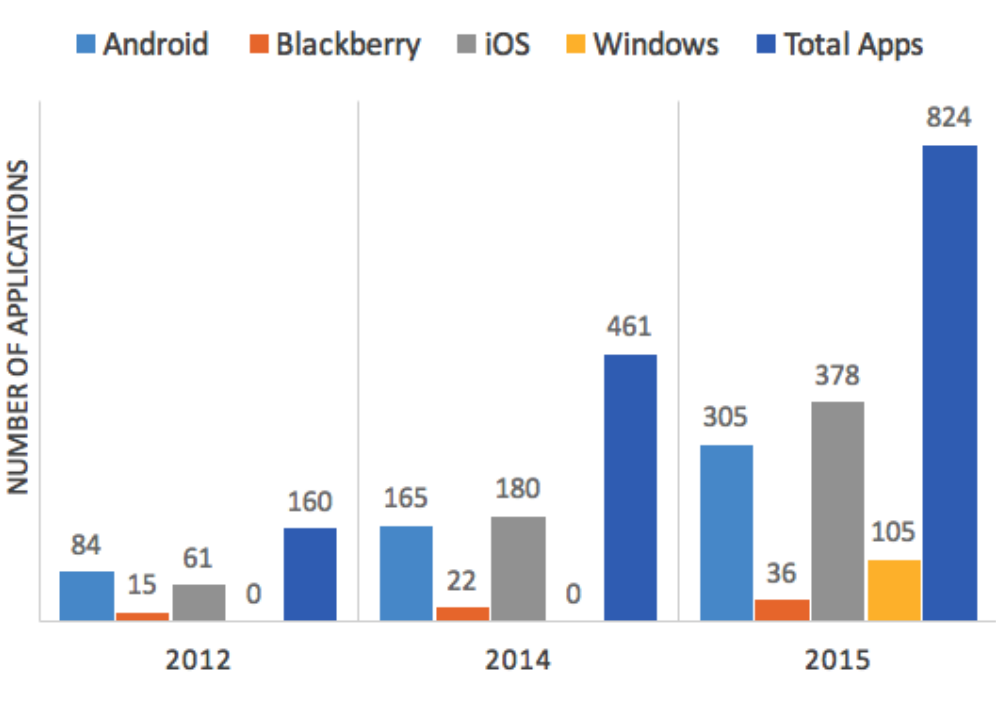
Figure 2. Changes in the online